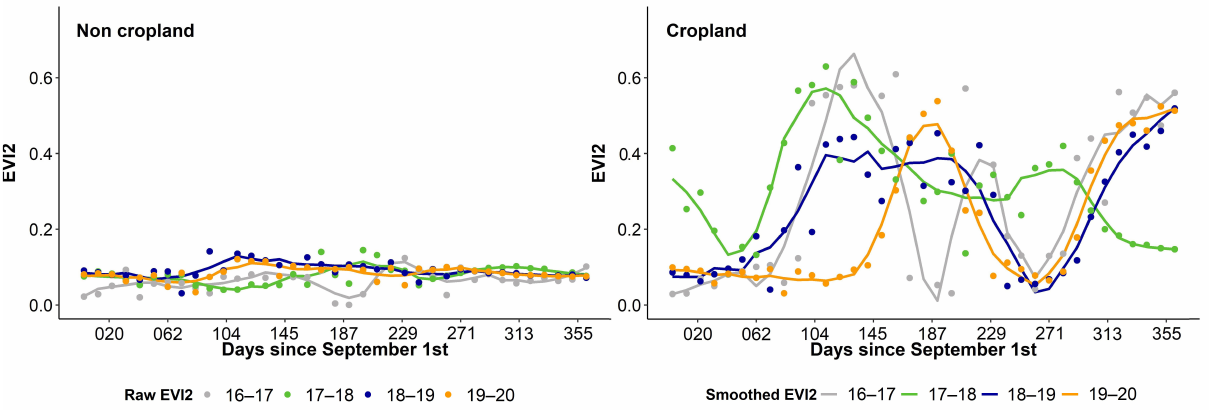
Figure 5. Raw and smoothed EVI2 time-series by S-G method of croplands, and non-croplands samples over four growing seasons from 2016–2017 to